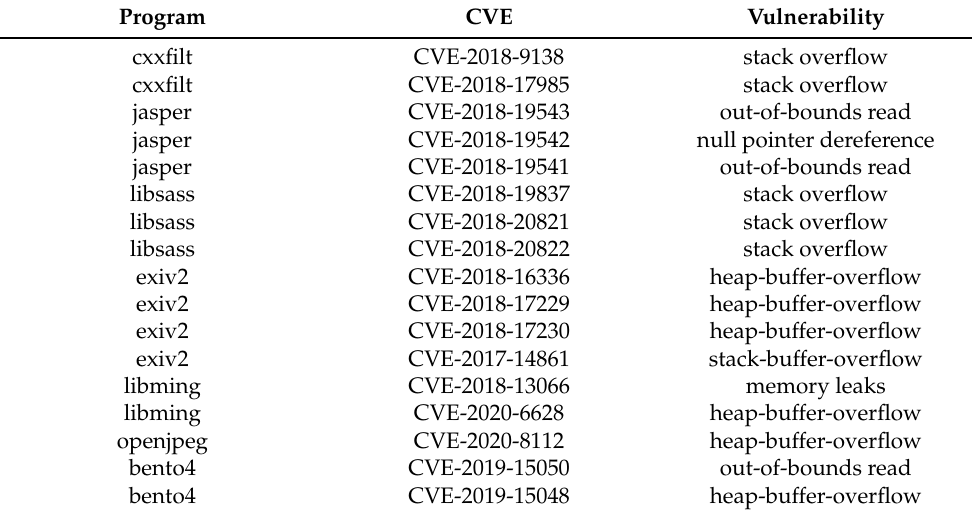
MooFuzz tests old version of the applications and analyzes related vulnerabilities to evaluate the ability in vulnerability detection. Table 5 shows the real vulnerabilities combination with its IDs identified by MooFuzz. MooFuzz is able to find stack overflow, heap overflow, null pointer dereference, and memory leaks related vulnerabilities. Table 5. Real-world vulnerabilities found by